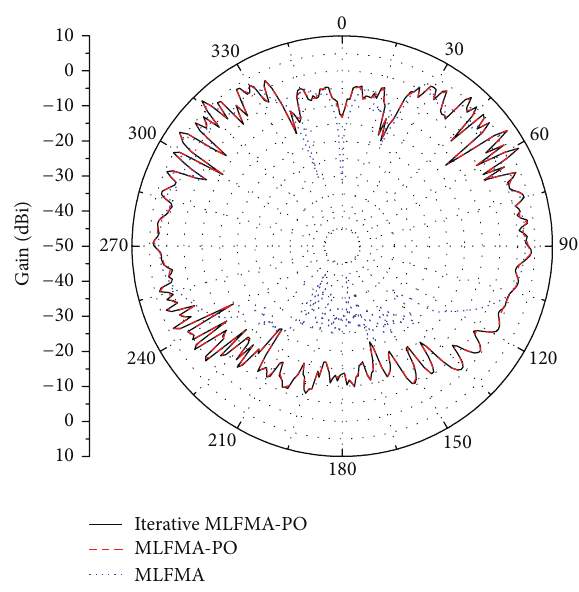
Figure5:Thefar-fieldgainpatterninXOZplaneofthewireantenna mounted on ship model.